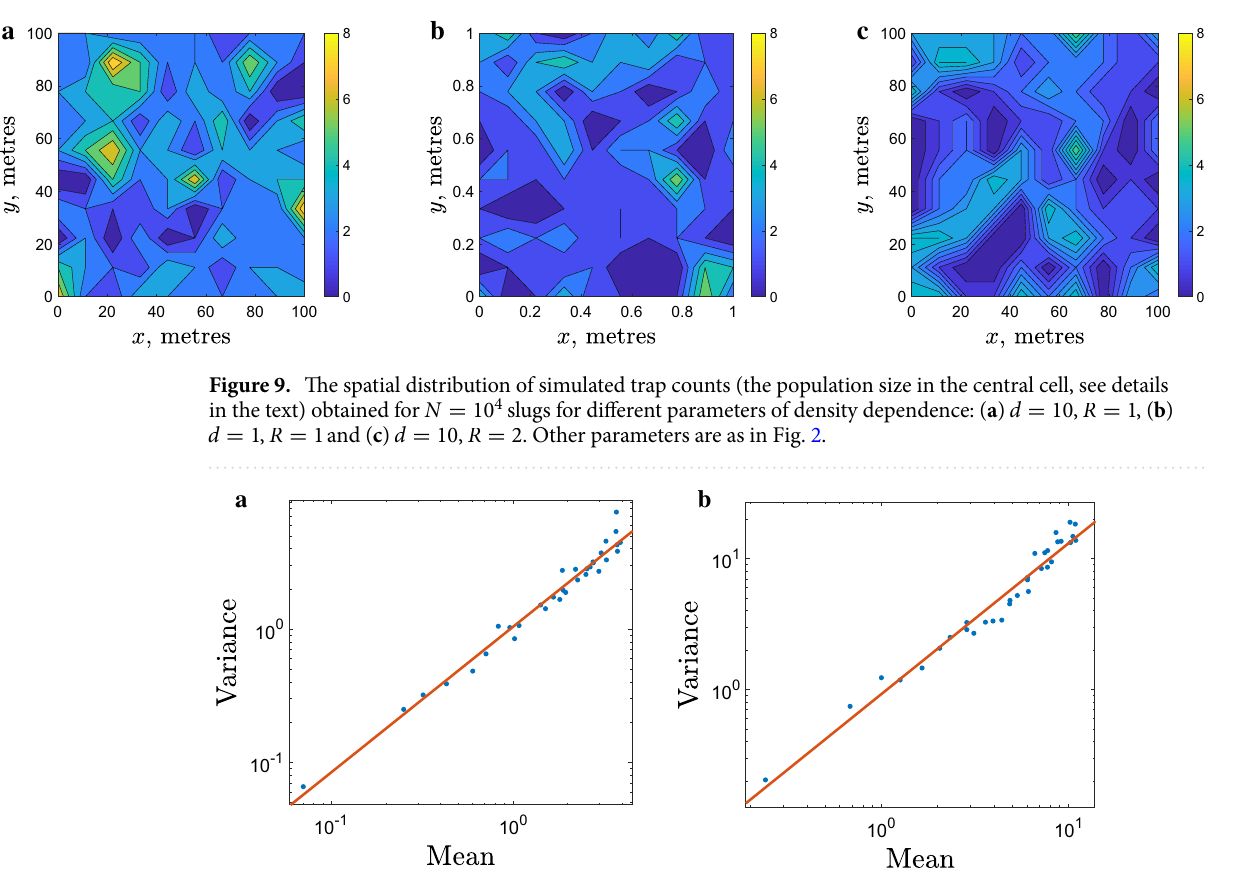
Figure 10. The trap count variance plotted against the mean trap count (shown on a log-log scale) calculated 5 cells: using the central sub-bin in each of 100 large bins for two different number of sub-bins. ( a ) 5 × log ( v ) 1.091 log ( m ) 0.4007 , r 2 1.151 log ( m ) 0.07845 , r 2 0.9739 ; ( b ) 3 3 cells: log ( v ) 0.9636 . = + = − = × = Slug movement parameters are the same as in Fig. 7. Before calculating the binned population numbers, the 10 4 time steps to ensure that the emergence of a fully developed initial spatial distribution was run for t = patchy